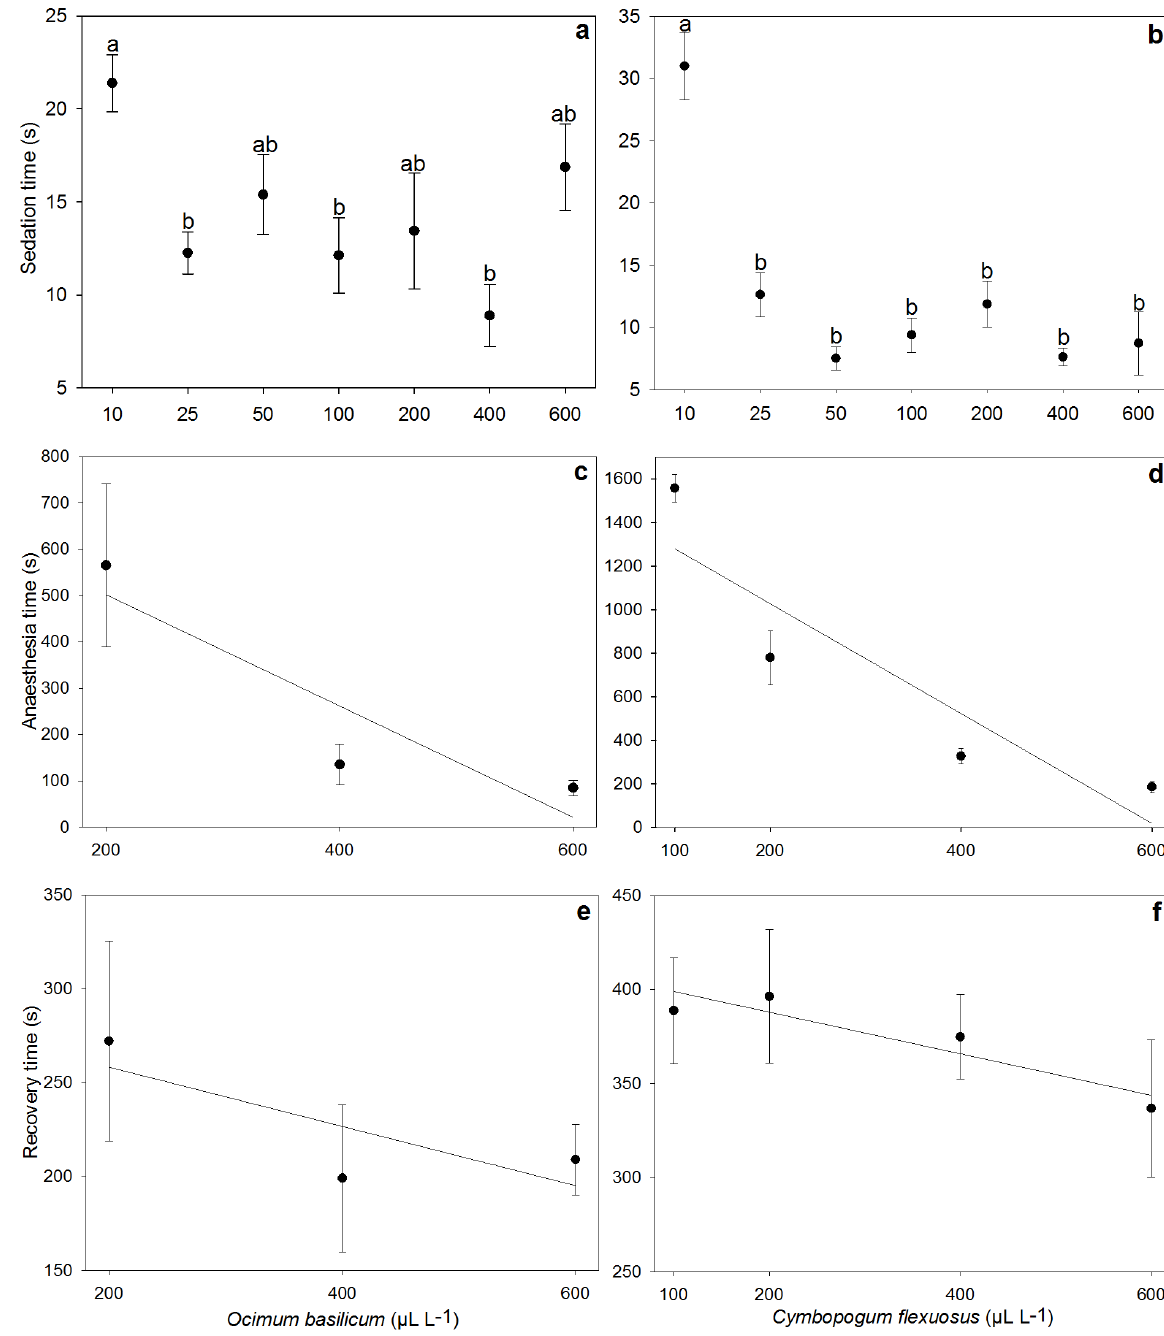
Figure 1 - Time required for the sedation ( a and b ), induction of anesthesia ( c and d ) and recovery ( e and f ) of tambacu using the essential oils of Ocimum basilicum and Cymbopogon flexuosus . a and b: different letters in the column indicate significant difference between concentrations. c : y= 741.83 – 1.20x; r²= 0.83. d : y= 1531.42 – 2.52x; r²= 0.82. e : y= 289.87 – 0.16x; r²= 0.64. f : y= 410.03 – 0.11x; r²= 0.86. Where y = Time (s) and x = Essential oil concentration (µL L -1